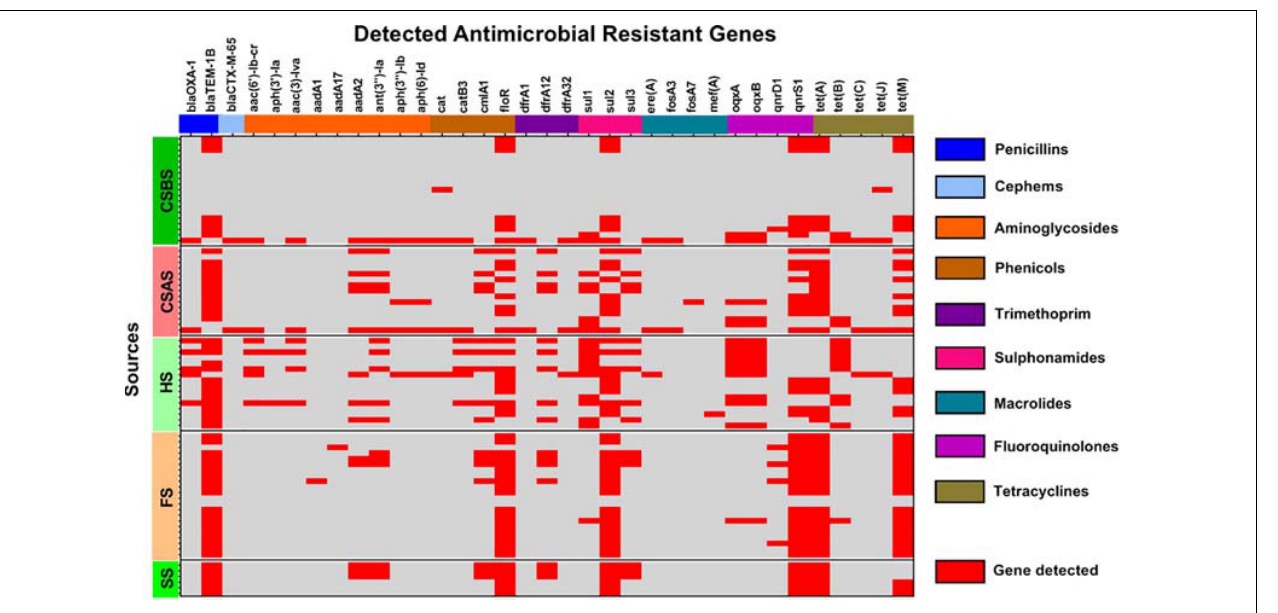
FIGURE 3 | Heatmap of the detection of antimicrobial resistance genes among the studied Salmonella isolates ( n =